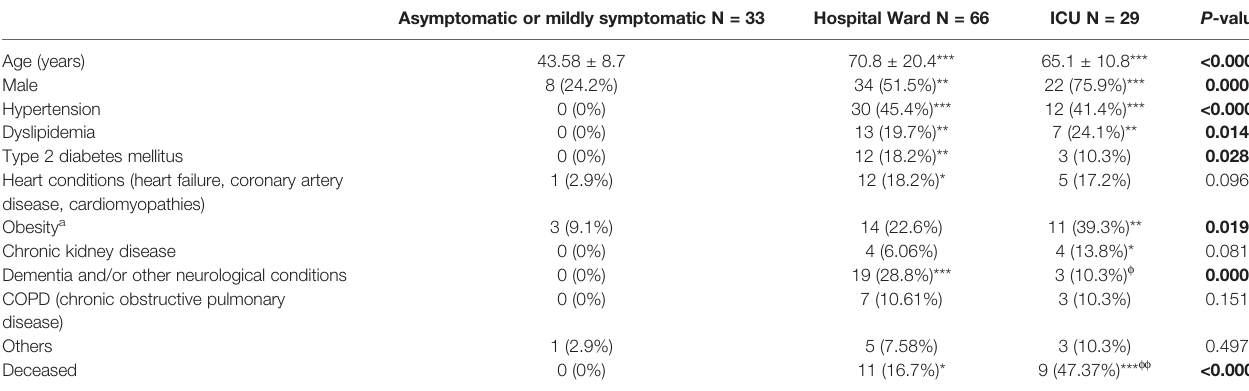
TABLE 1 | Clinical and demographic characteristics of COVID-19